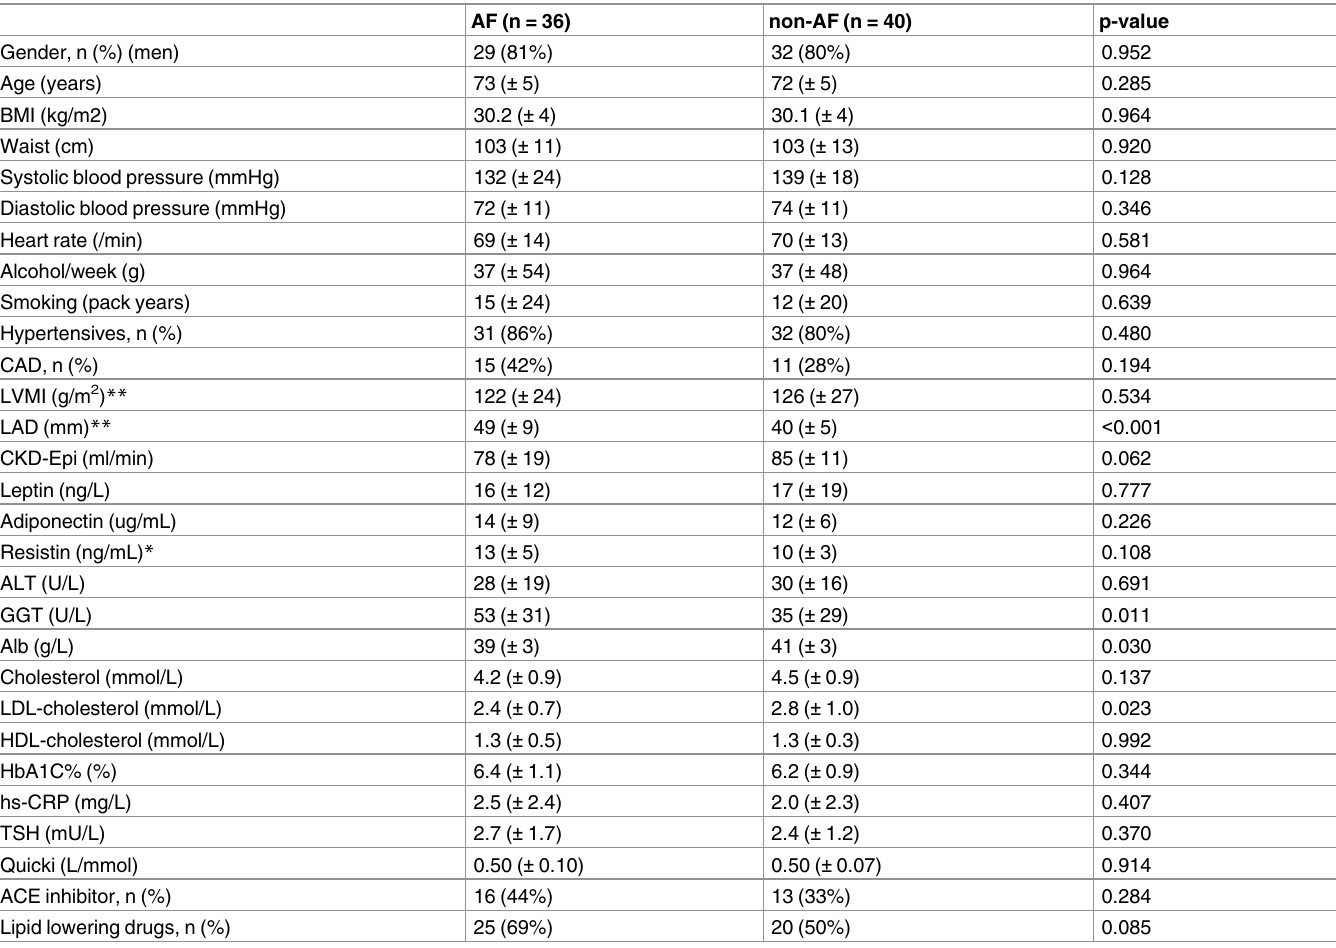
Table 1. The characteristics of the study subjects with transient elastography measurement (n = 76) available by AF